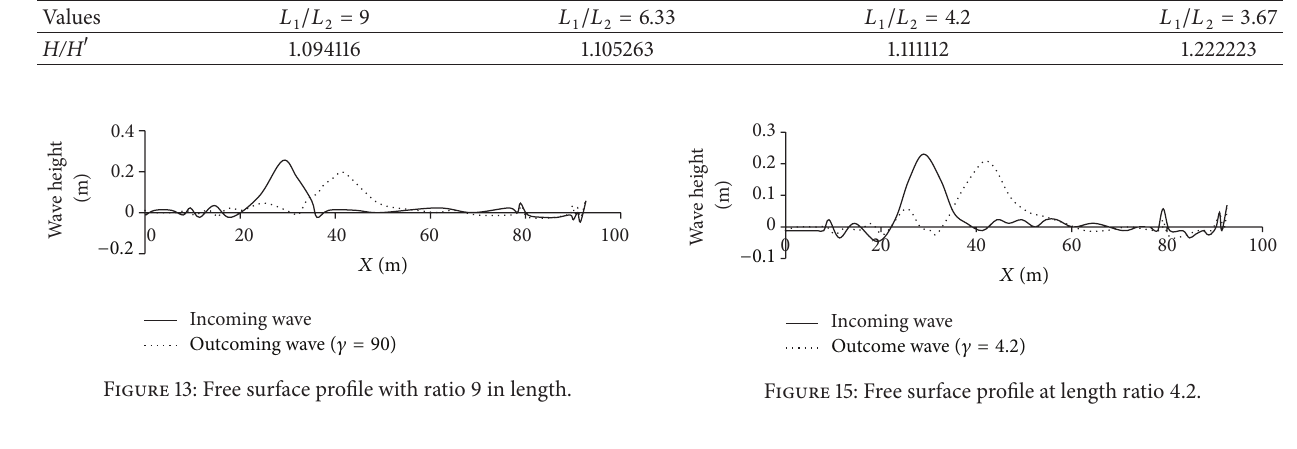
Table 6: Exact evaluation of length ratio effect on free surface reduction.